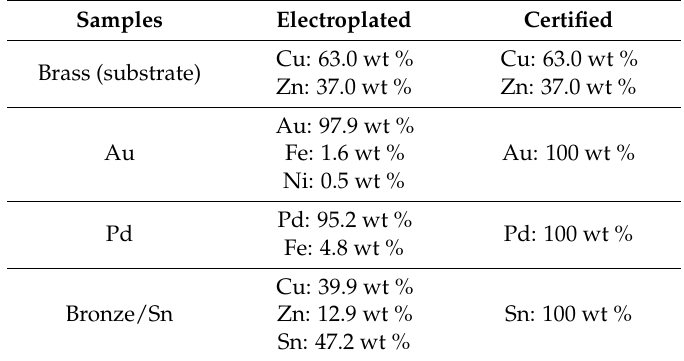
Figure 3. FIB-SEM images of the electroplated samples: ( a ) gold; ( b ) palladium; and ( c ) white bronze. Table 1. The composition of the substrate and the film investigated using EDS analysis.